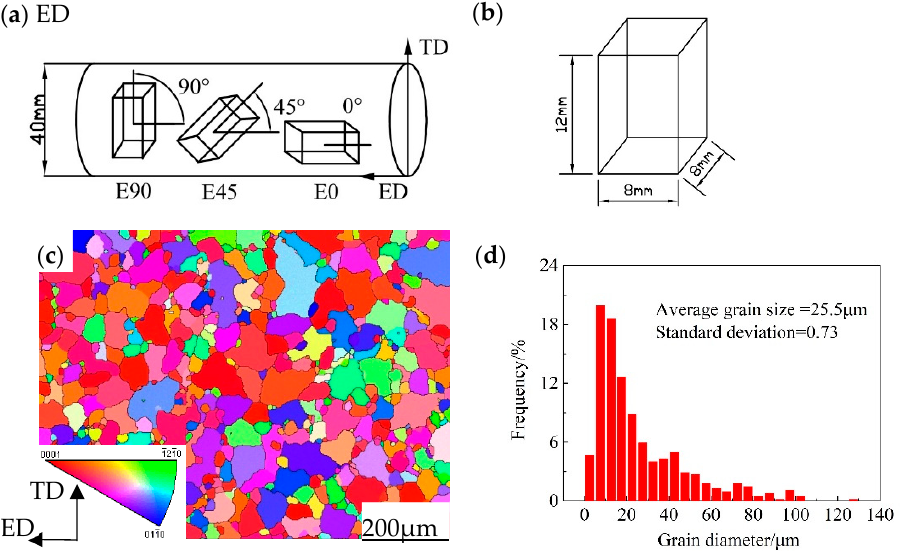
Figure 1. Sample shape and size: ( a ) schematic of samples; ( b ) compression samples; ( c ) inverse pole figure map; ( d ) grain size distribution.